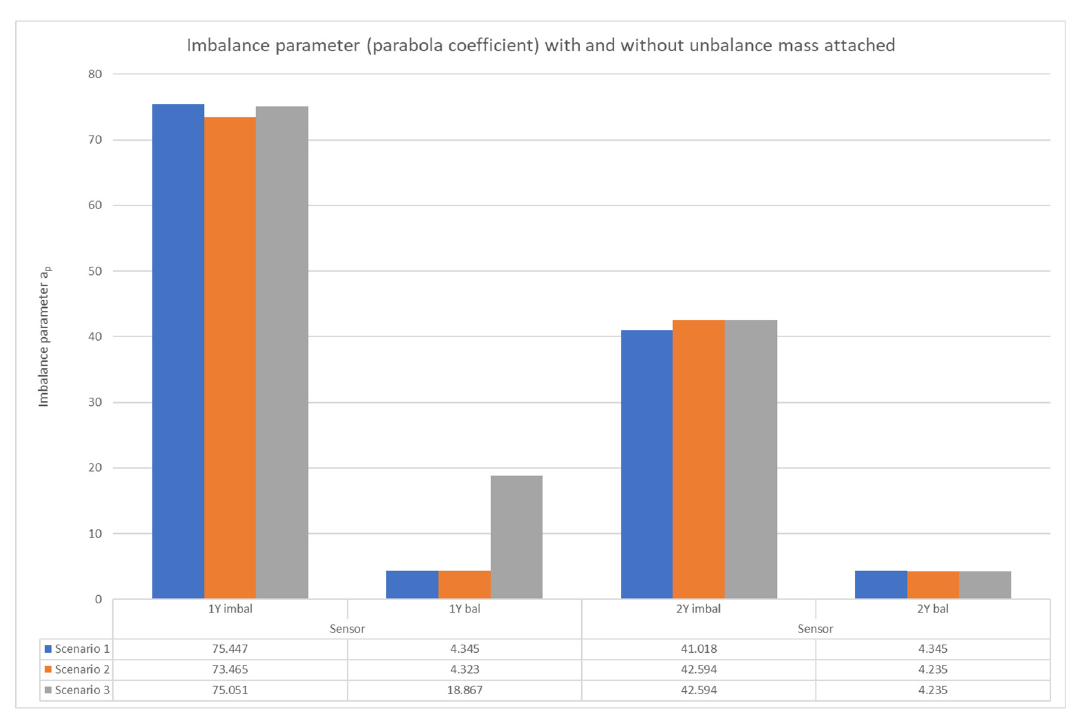
Figure 10. Imbalance coefficients for sensor 1Y and 2Y.